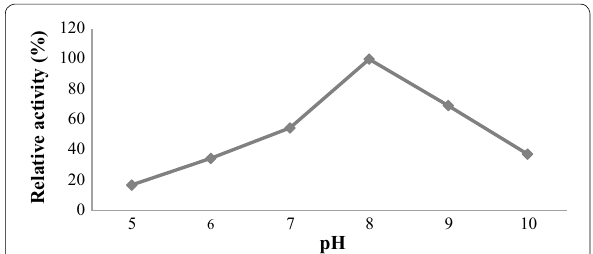
Fig. 6 Effect of pH on keratinase activity. Enzymatic reaction was carried out at different pH ranging from (5 to 10) for 10 min at 40 °C in a shaking water bath and results are presented on graph. Data represent the means of triplicate